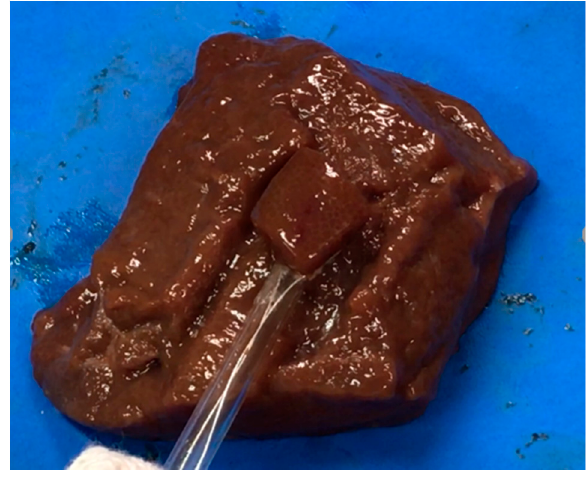
Figure 14. Heating with the microwave snare.